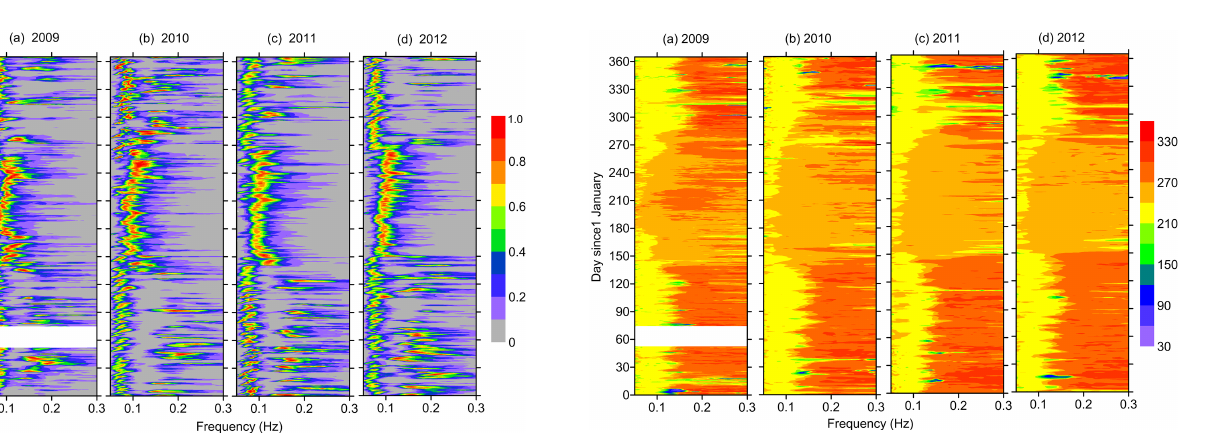
Figure 4. Temporal variation in mean wave direction during 2009– 2012. The contour levels are the mean wave direction in degrees. The white patch indicates the gap in the data.